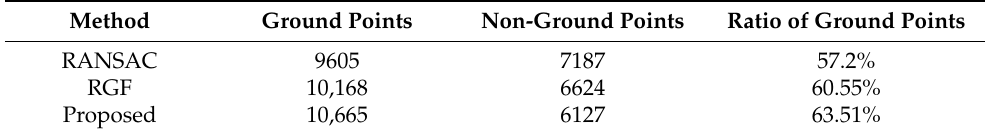
Table 3. Statistics of ground points and non-ground points in Figure 11.